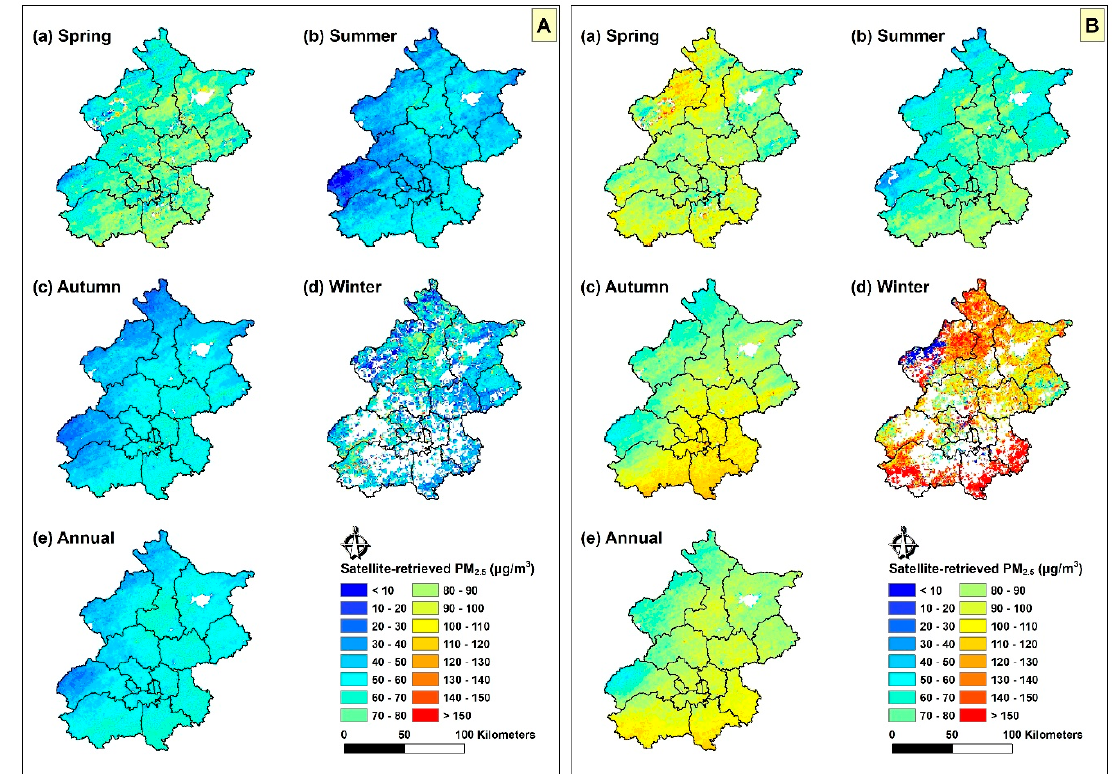
Figure 8. Seasonal-spatial distribution of ( A ) PM 2.5 predictions from the first-stage non-nested TFER model, ( B ) PM 2.5 predictions from the non-nested overall model. ( a – e ) correspond to spring, summer, autumn, winter, and annual in subfigures ( A , B ).